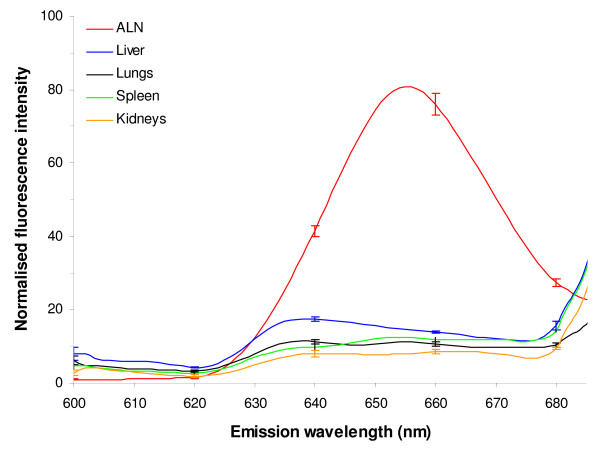
Normalised fluorescence emission spectra of organs extracts. ALN, spleen, kidneys, lungs, liver were chemically solubilised 24 h after subcutaneous injection of 20 pmol of QDs. Fluorescence spectra of the extracts were then recorded. Error bars represent SEM. ALN: Axillary Lymph Node; QDs: Quantum Dots.